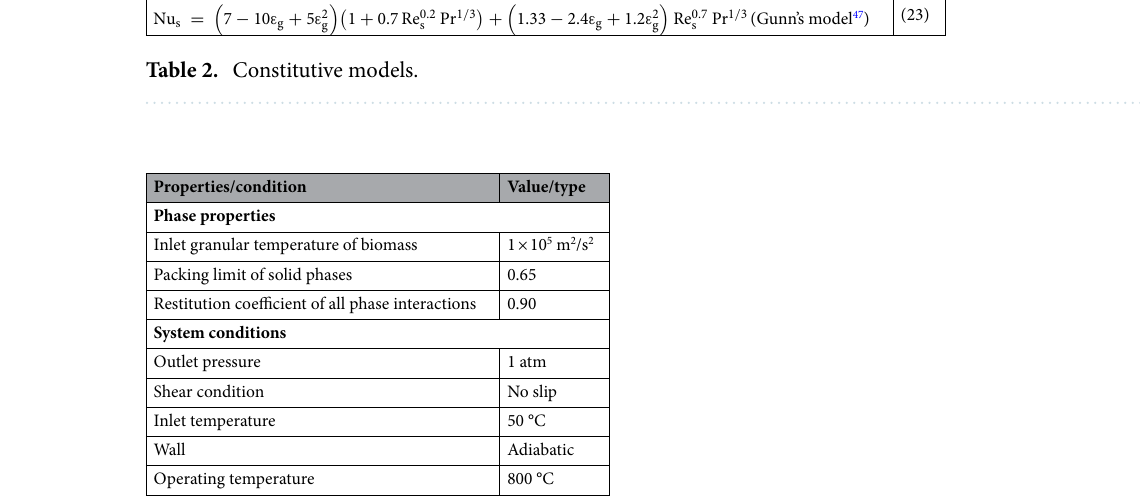
Table 3. Hydrodynamic properties and system conditions used in the